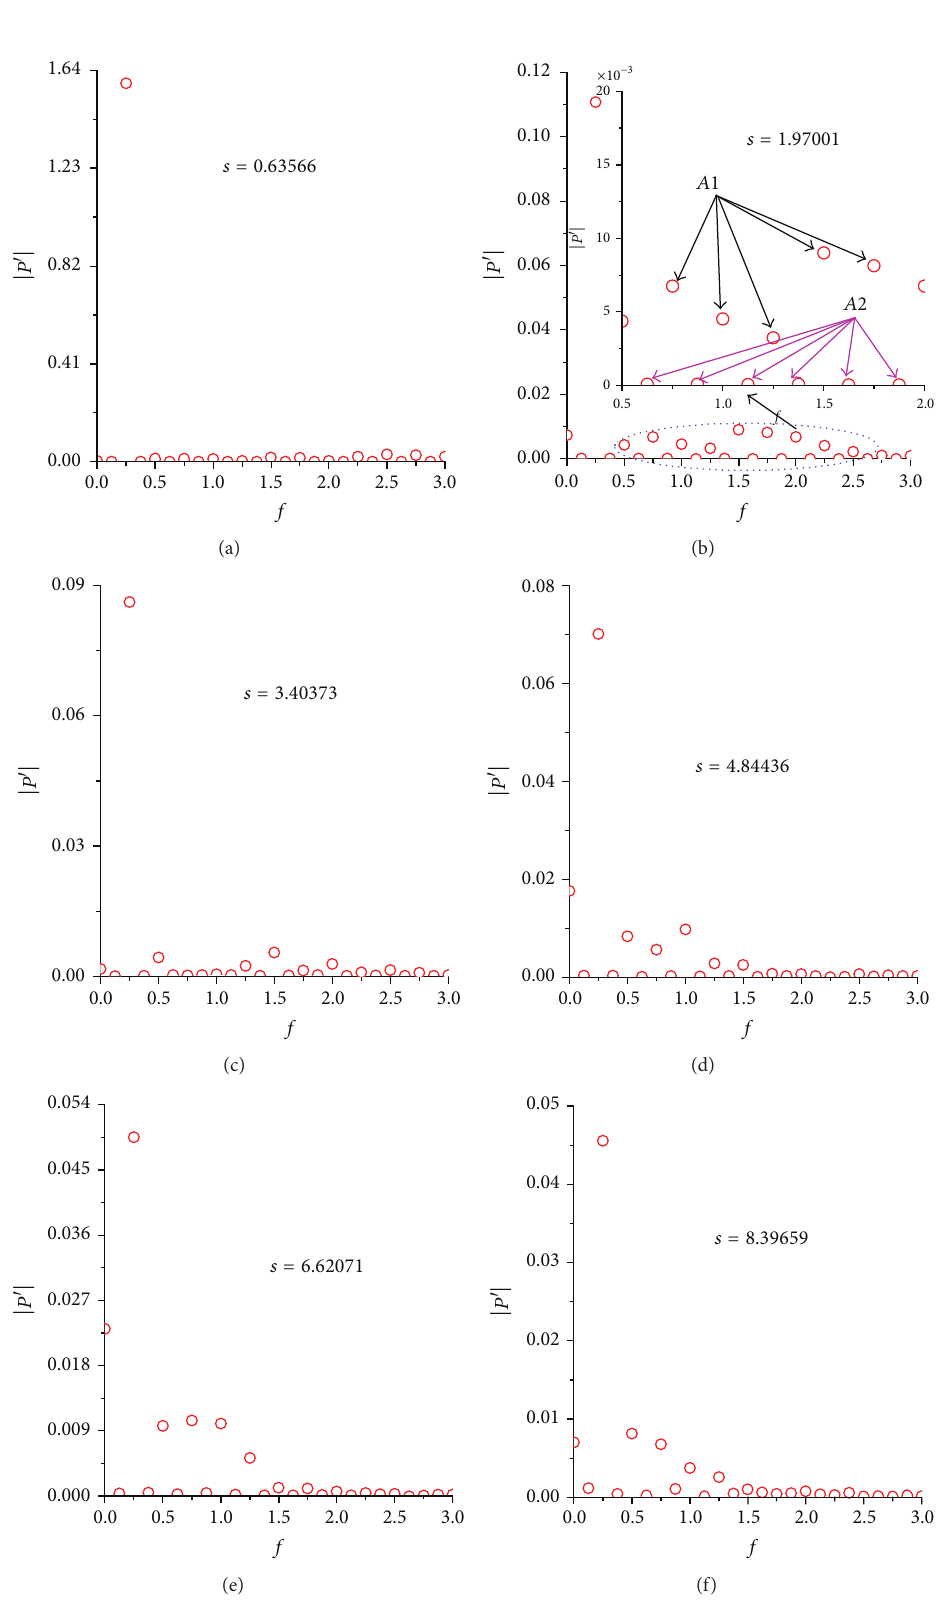
Figure 8: Frequency spectrum analysis of pressure disturbance at different locations in the period